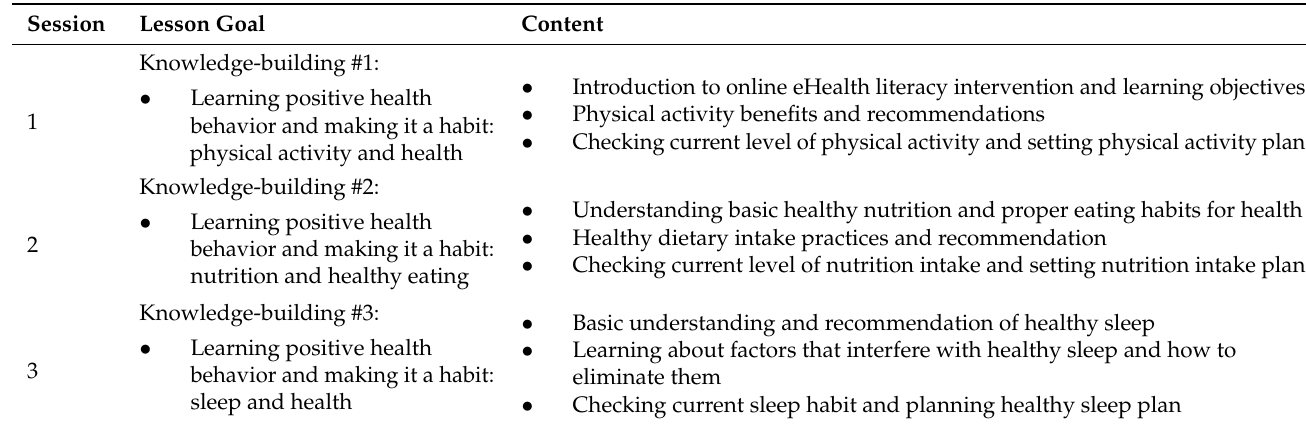
Table 1. eHealth literacy education program